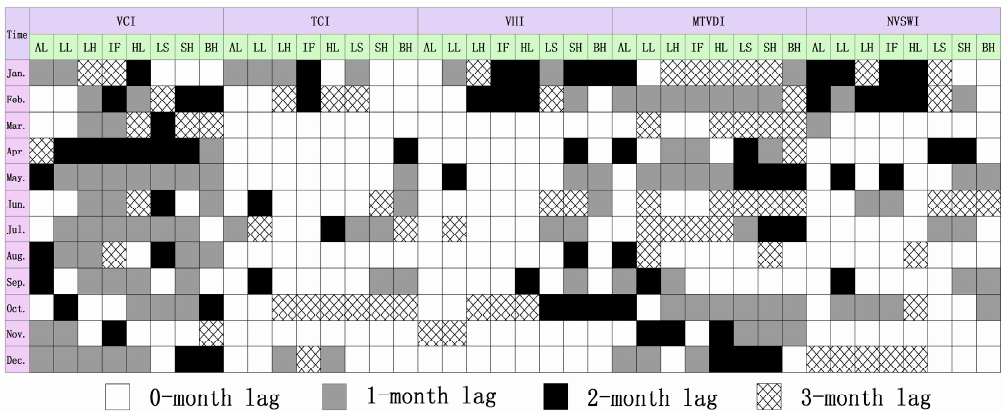
Figure 10. Time-lags of remotely sensed drought indices (RSDIs) in the Yellow River basin (YRB).